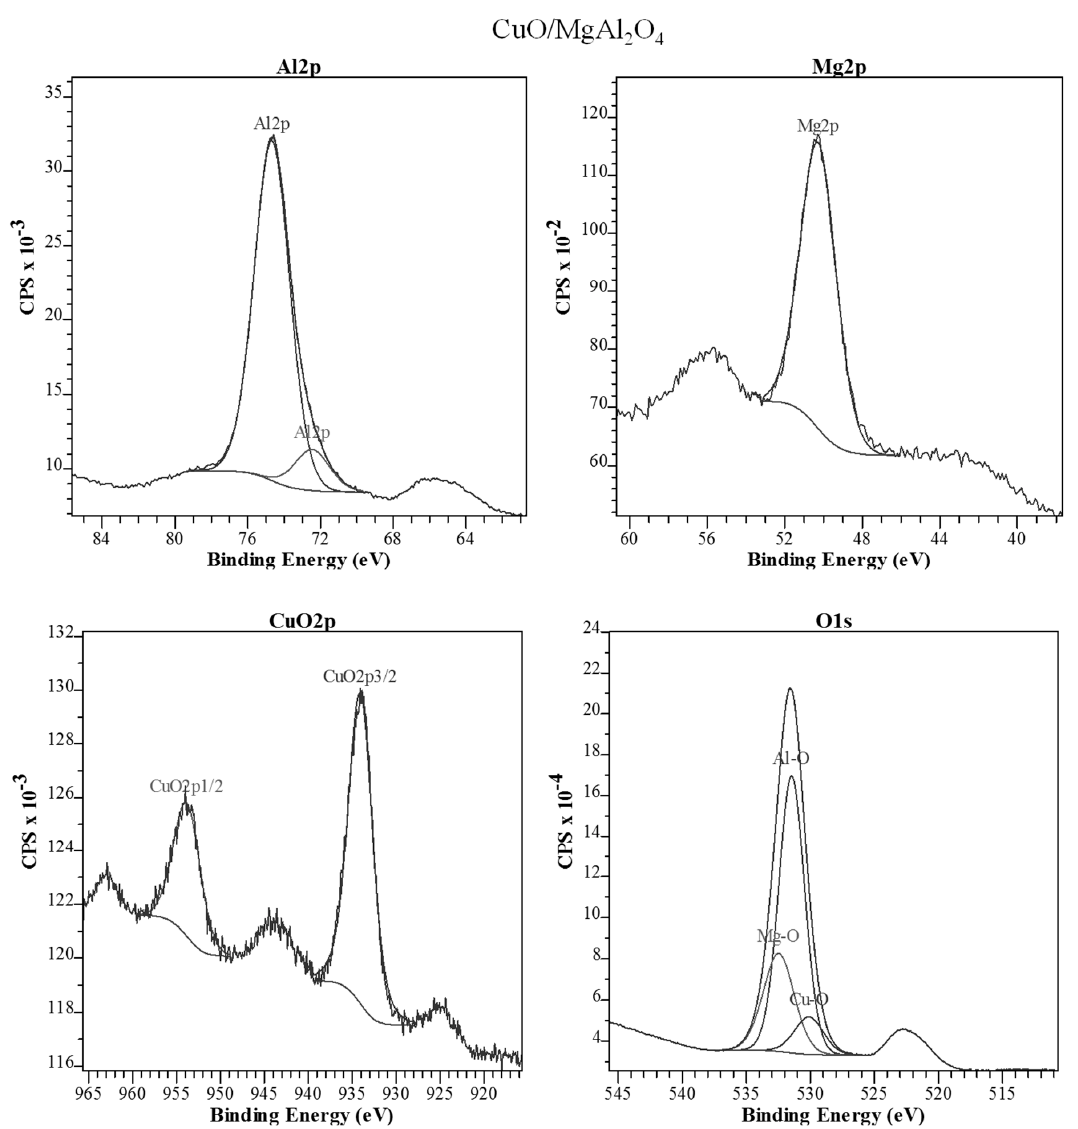
Figure 6. XPS data of CuO/MgAl 2 O 4 nanocatalyst.